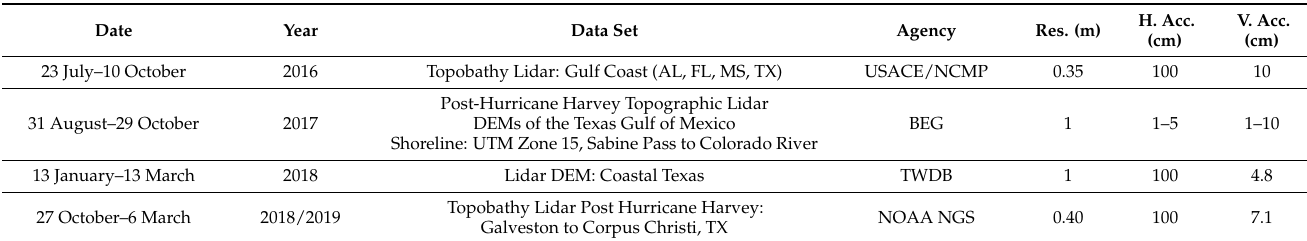
Table 1. Elevation data sets used in the post-storm change analysis and monitoring of beach-dune profiles in succeeding